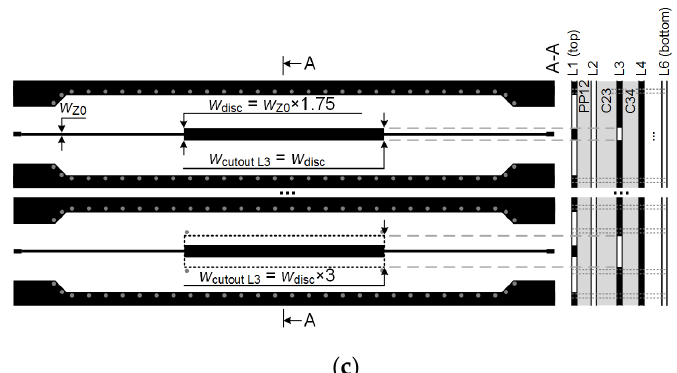
Figure 3. DUT structure description: ( a ) simplified description of the ratio between track, discontinuity, and cut-out; ( b ) detailed board top and side views with a track-to-discontinuity ratio of 1:1.75 and a single cut-out; ( c ) detailed board top and side views with a track-to-discontinuity ratio of 1:1.75 and a two-layer cut-out.